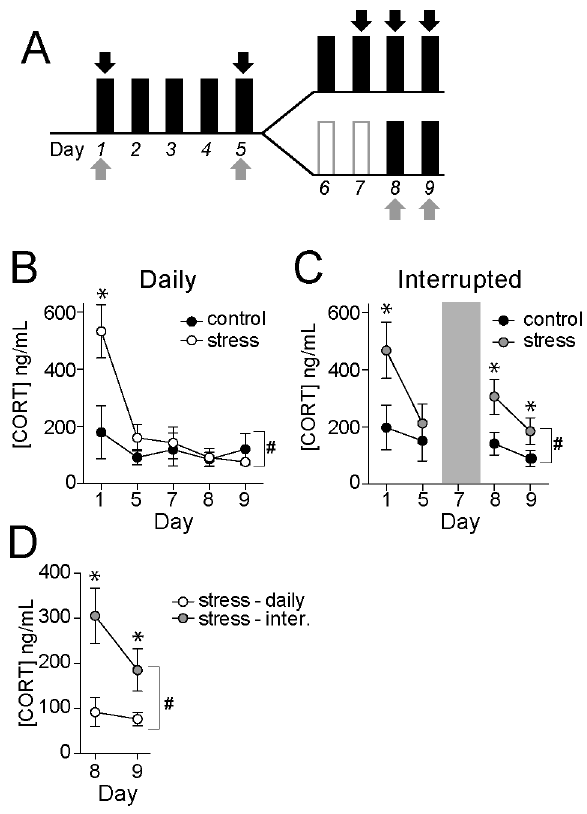
Figure 5. Interrupted stress leads to greater corticosterone response to restraint stress. A) Corticosterone levels were sampled on days 1, 5, 7, 8 and 9 in the daily restraint groups, and days 1, 5, 8 and 9 in the interrupted restraint groups. B) Corticosterone levels displayed habituation to control levels by the 5 th day of restraint in the daily restraint group. C) Corticosterone levels displayed habituation to control levels by the 5 th day of restraint, but displayed recovery from habituation after the interruption in the interrupted restraint group. D) When directly compared, restraint elicited greater circulating cortico- sterone after interruption in the interrupted restraint group compared to the daily restraint group. * indicates p , 0.05 in post hoc tests after significance in a two-way repeated measures ANOVA. # indicates significant Pattern x Day interaction in a two-way ANOVA.